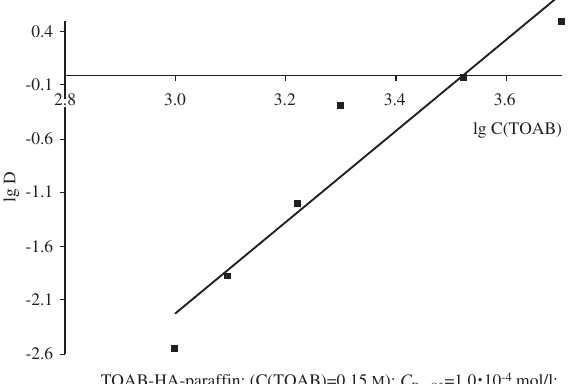
Figure 2 The logarithmic dependence of the distribution coeffi cients of Re (VII) on the concentration of TOAB in the organic